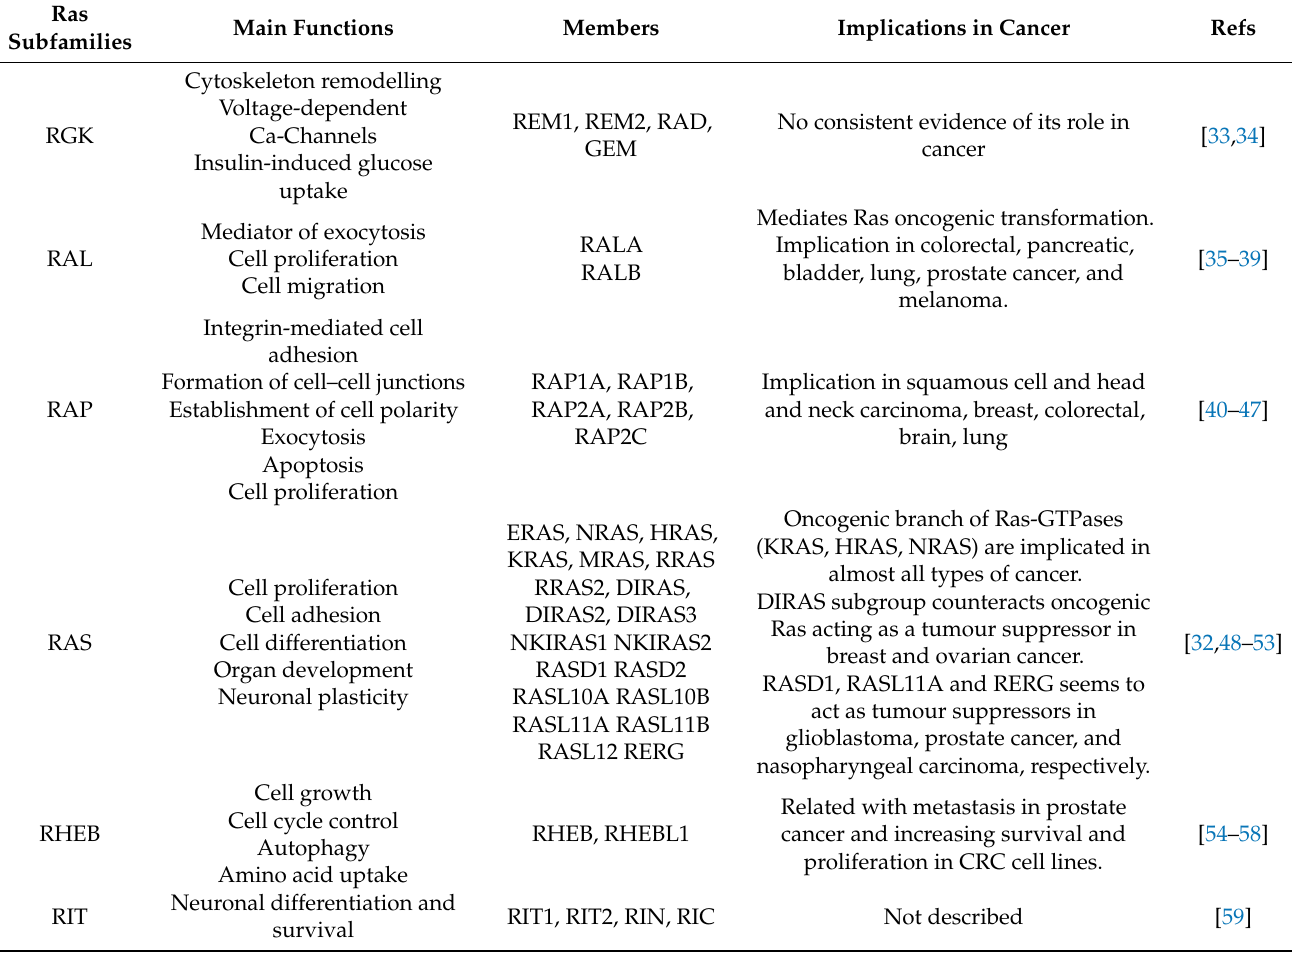
Table 1. Members of Ras-GTPase family, functions, and its implications in cancer. Ras-GTPase family is formed by 6 subfamilies (RGK, RAL, RAP, RAS, RHEB and RIT), most of them implicated on development and progression of several types of